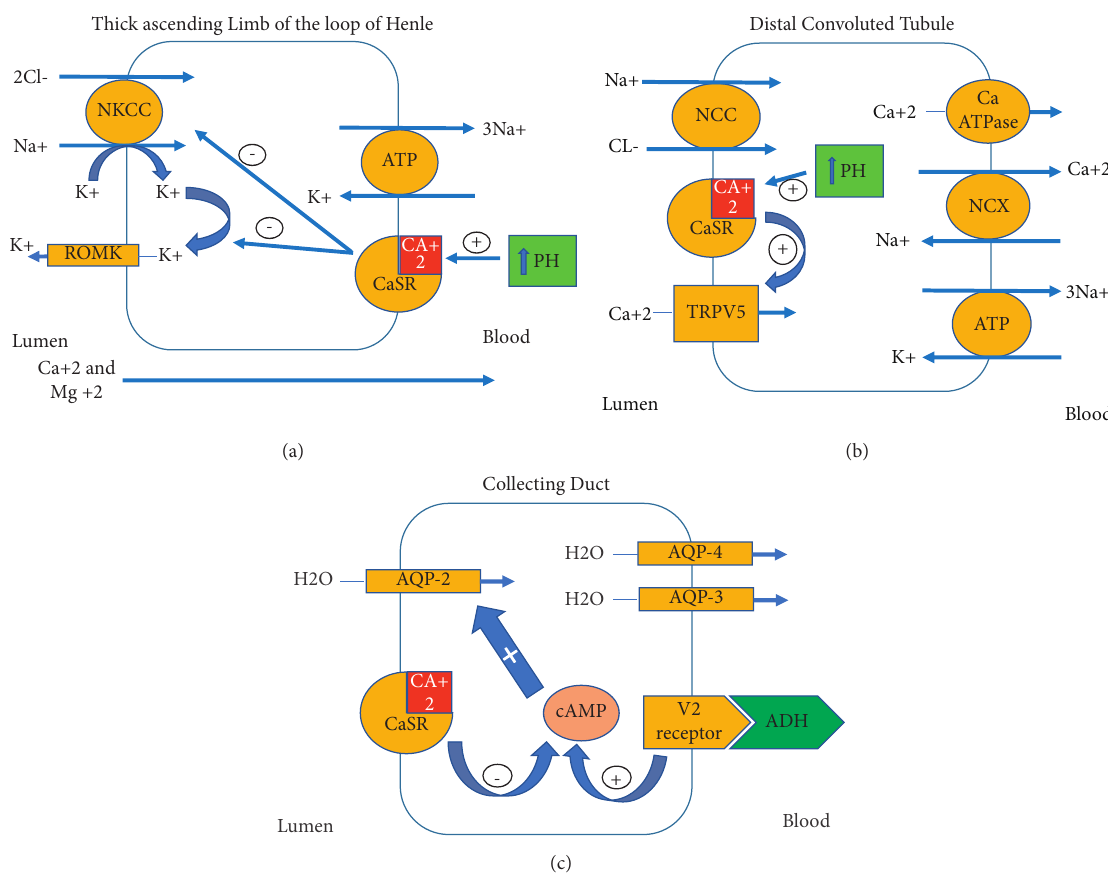
Figure 1: (a) Thick ascending limb of the loop of Henle. (b) Distal convoluted tubule. (c) Collecting duct.